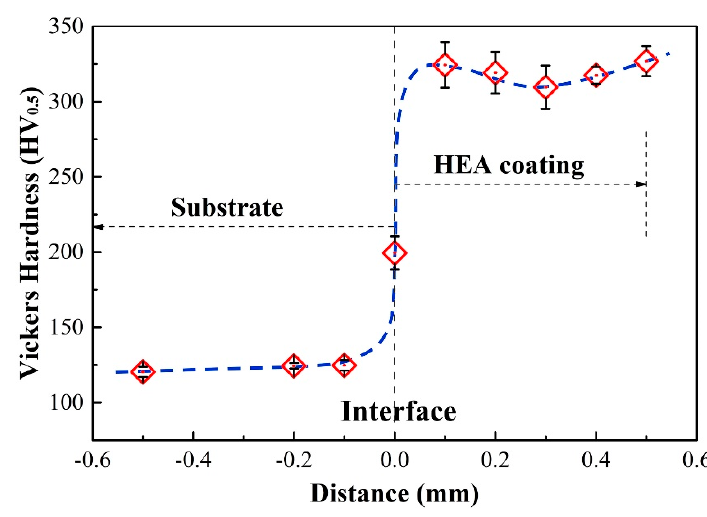
Figure 5. Microhardness distribution of (CoCrFeNi) 95 Nb 5 HEA coating.